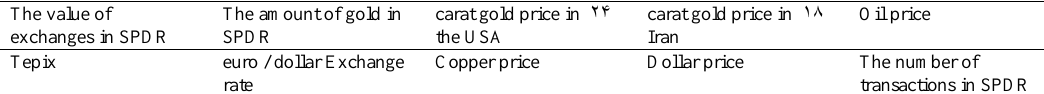
Table 2. The factors used as daily in the model.